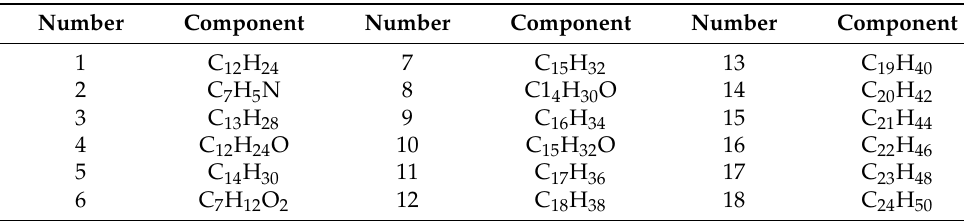
Table 1. Mass spectrometric analysis results of soil residual diesel components.